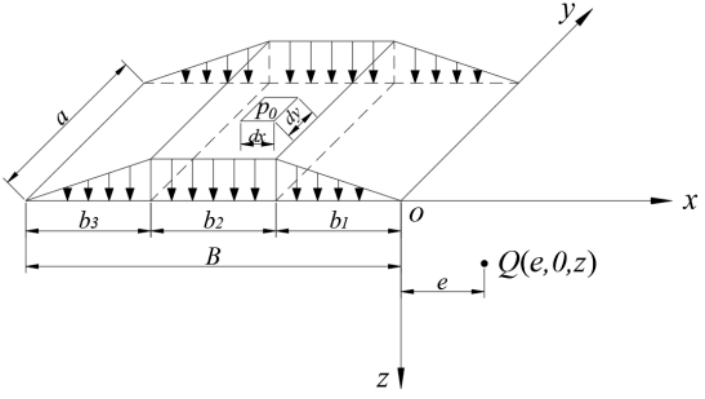
Figure 3. Diagram of the surcharge load.